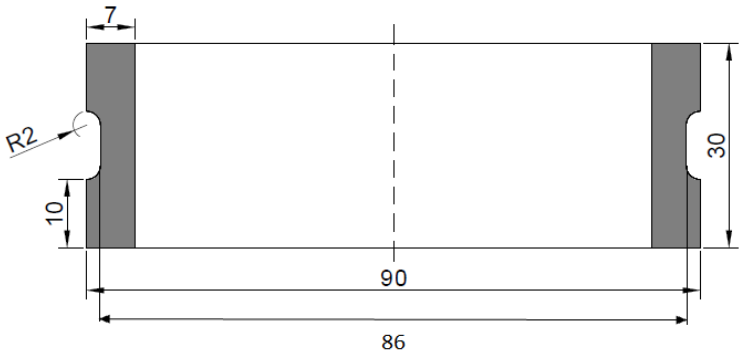
Figure 1. Detailed dimensions of the cylindrical hollow specimen for multiaxial mechanical